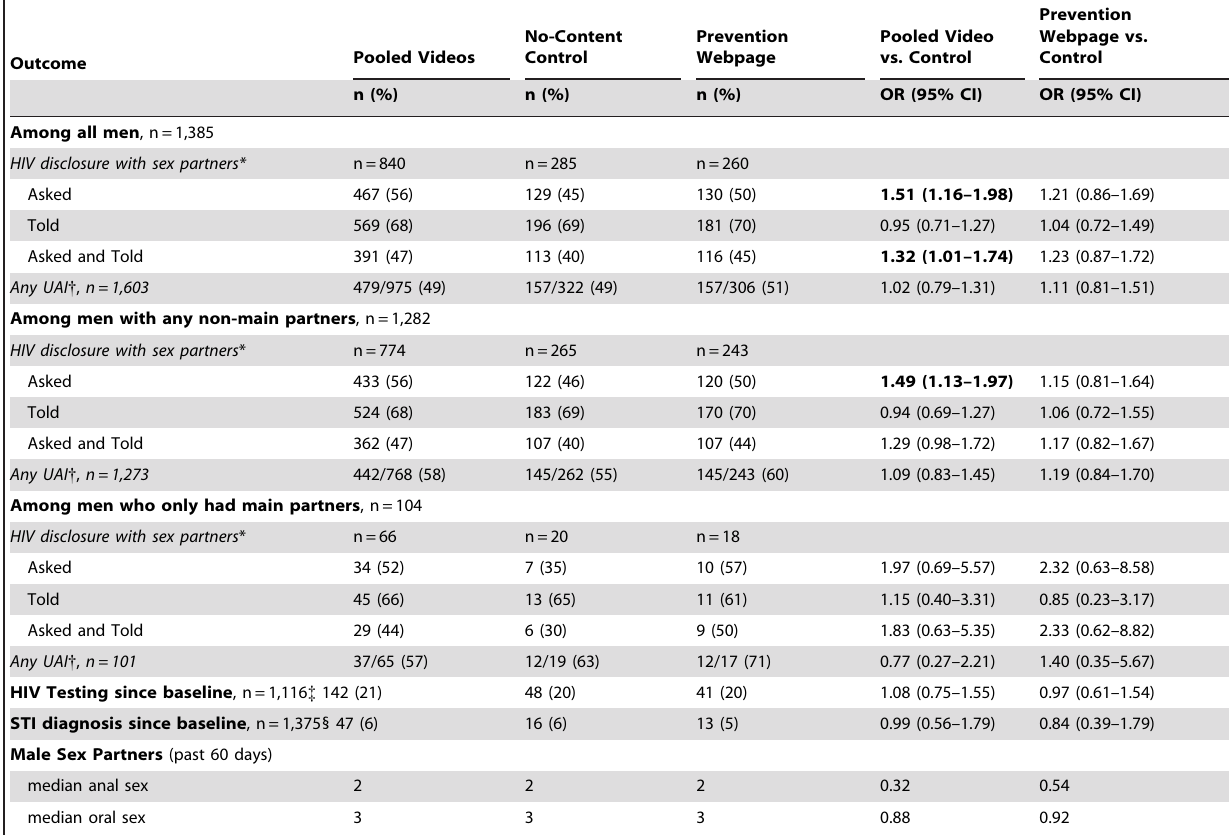
Table 3. Primary Outcome Behaviors at 60-Day